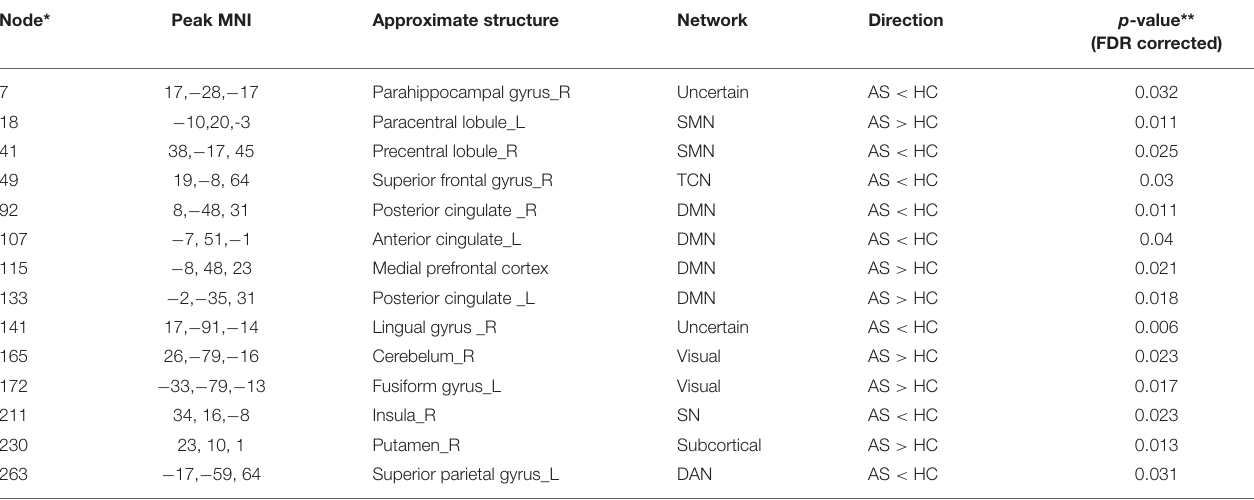
TABLE 3 | Gray matter volume differences between the AS patients and HCs. Node*